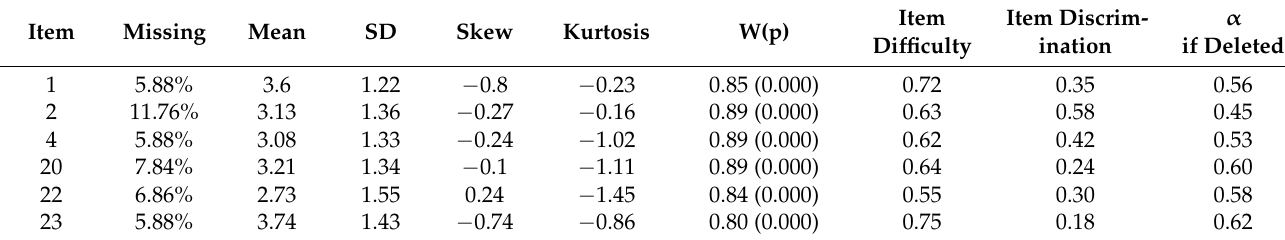
Table 5. Rasch analysis of the dimension 2 of the